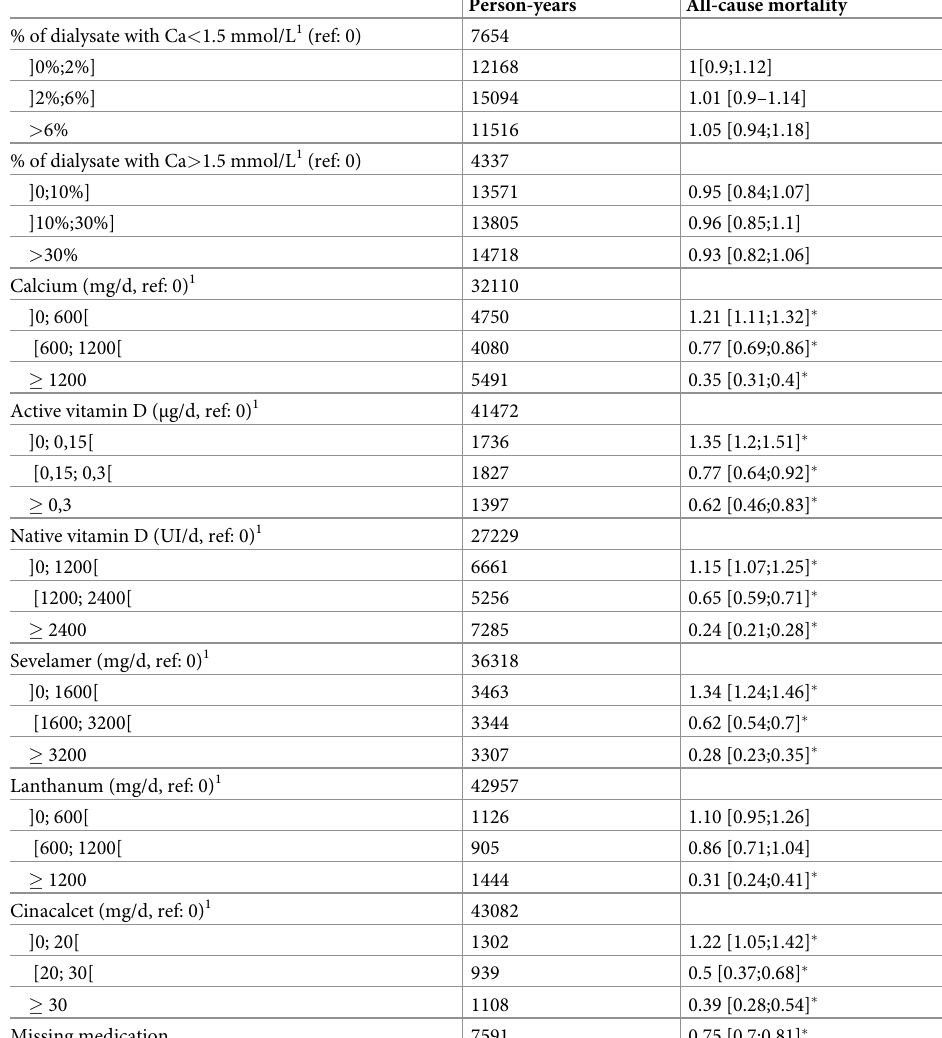
Table 7. Fully adjusted hazard ratio (HR) for all-cause and cardiovascular mortality, as a function of exposure to dialysate and to MBD treatments. Person-years All-cause mortality % of dialysate with Ca < 1.5 mmol/L 1 (ref: